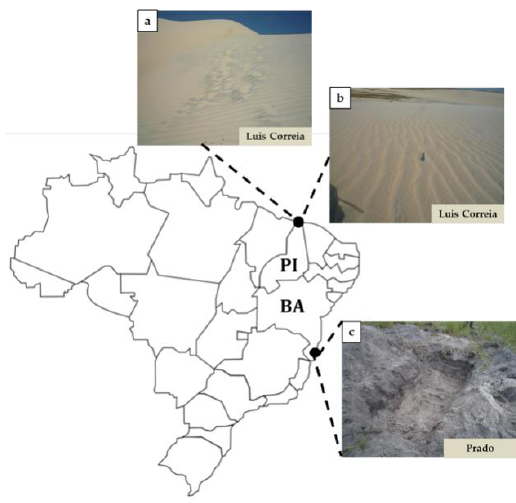
Figure 3. Sampled areas: LP ( a ), LC ( b ), and PA ( c ).